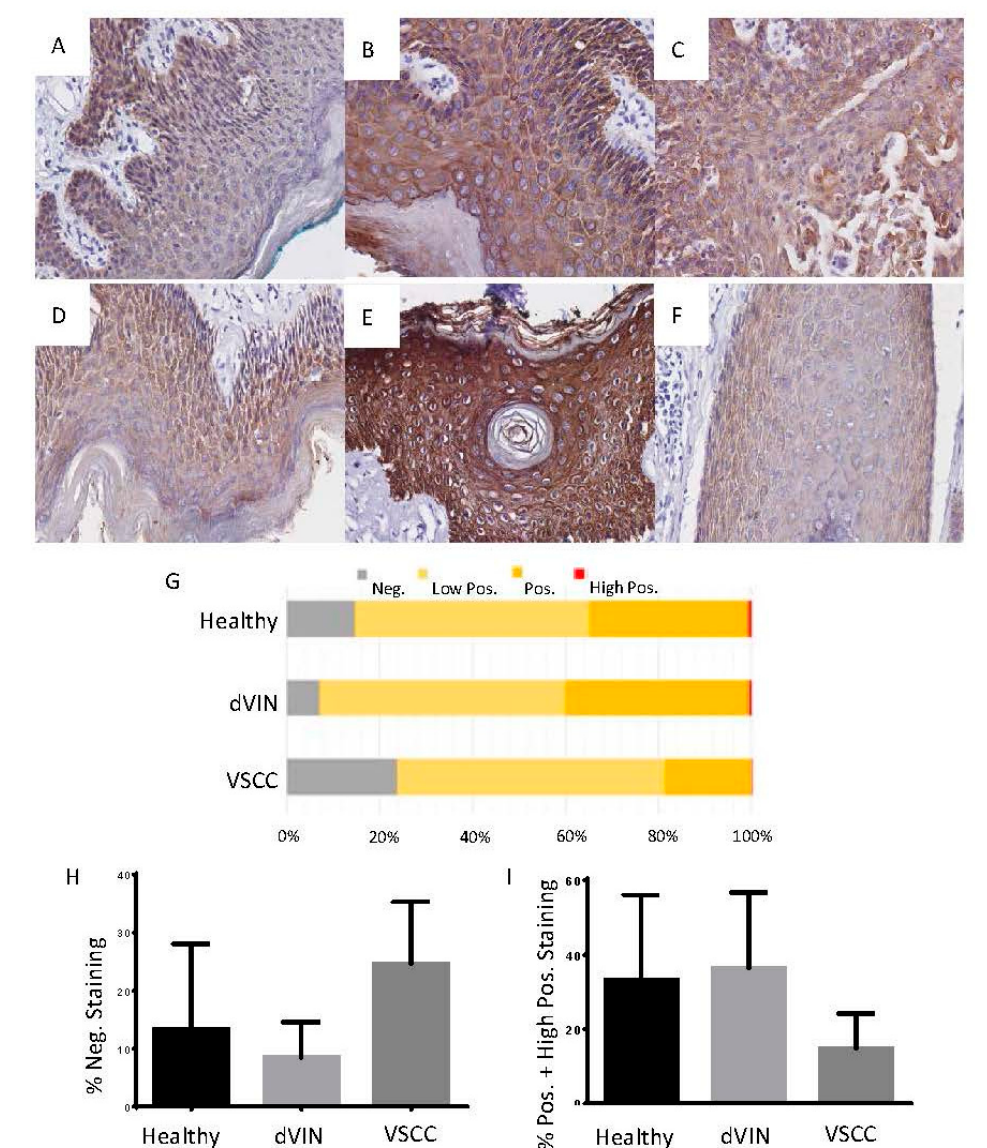
Figure 2. IHC analysis of CK5 on vulvar tissues containing regions of healthy epithelium, dVIN, and VSCC, all at 40× magnification. ( A ) CK5 staining of healthy epithelium; ( B ) dVIN; ( C ) VSCC from a